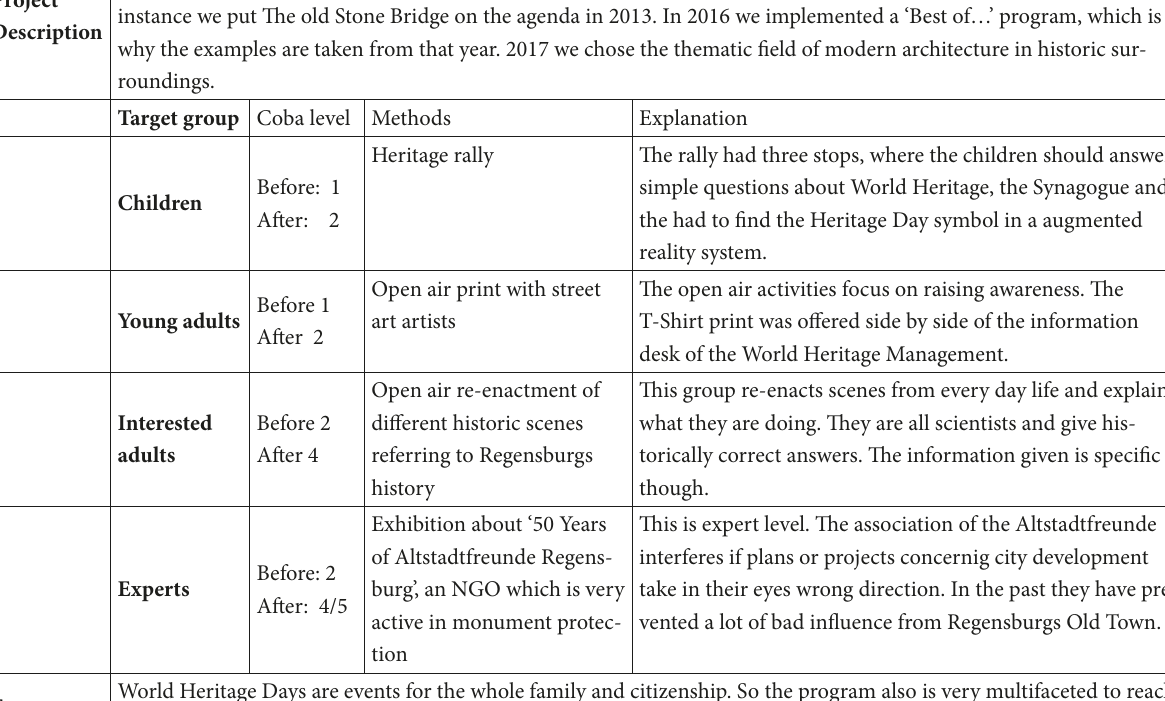
Table 3 Activities for families during World Heritage Days